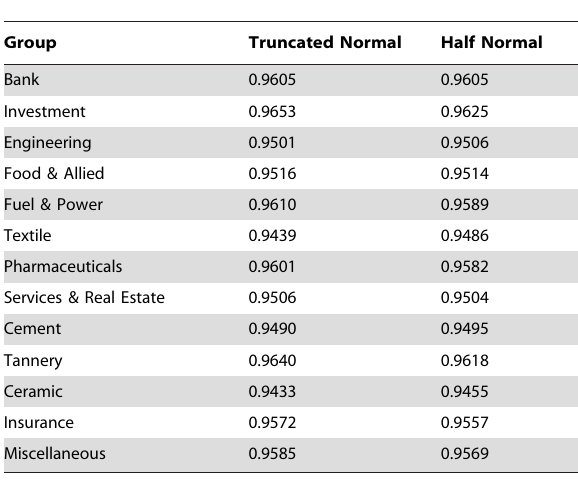
Table 5. Group-wise Mean Efficiency in Dhaka Stock Exchange by distribution with Time-variant.